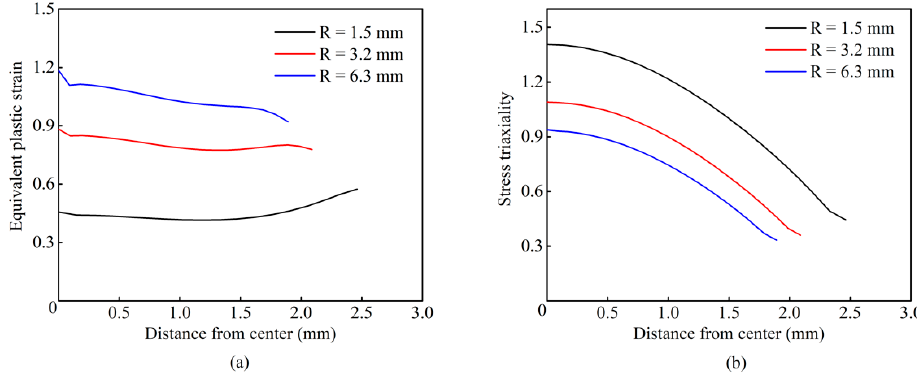
Figure 9. Distribution of stress triaxiality and equivalent plastic strain over notch section for SNT tensile specimens (M1, M3, and M5): ( a ) stress triaxiality; and ( b ) equivalent plastic strain.